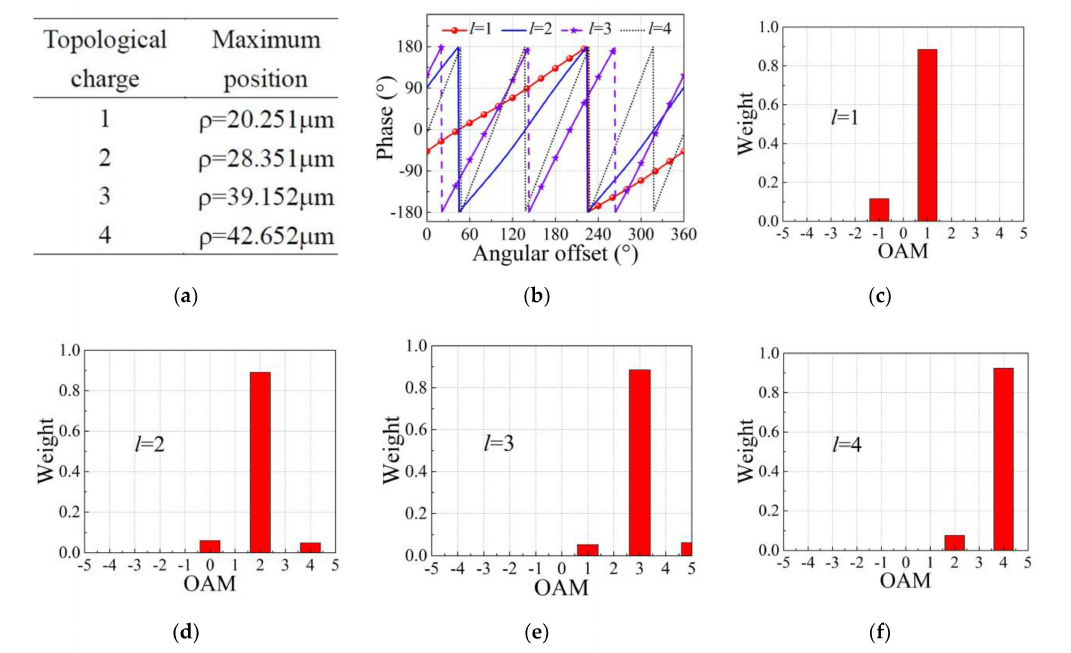
Figure 12. The information of the external field in the far region after the beam is scattered by a uniform and isotropic spherical particle: ( a ) lists the position of the maximum intensity of the corresponding external field in the polarization direction where the beam is incident with a different topological charge; ( b ) shows the sampling phase along the circle where the maximum lies; and ( c – f ) are the spiral spectra of the entire external fields. The measurement plane is located at z = 50 µ m.